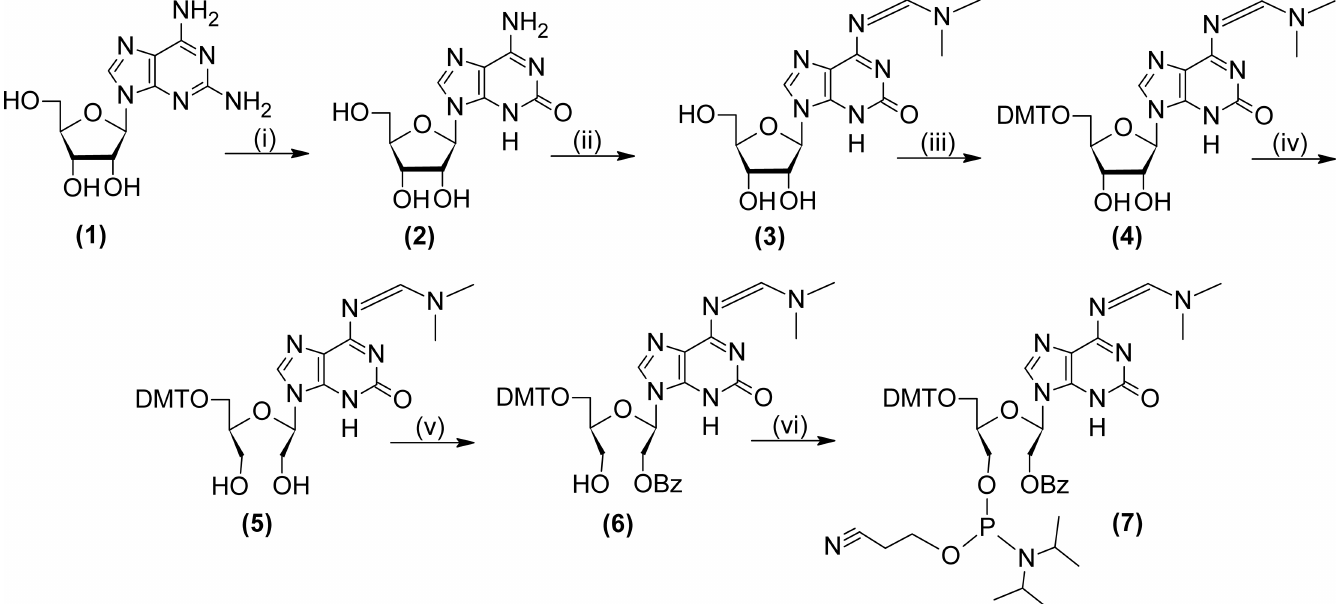
Fig 2. Chemical synthesis of UNA-isoguanine phosphoramidite. Reagents: (i) LiNO 2 , AcOH, H 2 O; (ii) N , N -dimethylformamide dimethyl acetal, DMF; (iii) DMTCl, Py; (iv) NaIO 4 , 1,4-dioxane/water; NaBH 4 , 1,4-dioxane/water; (v) BzCl, DCM, -70˚C; (vi) 2-cyanoethyl- N , N , N 0 , N 0 -tetraisopropylphosphordiamidite, tetrazole, MeCN.